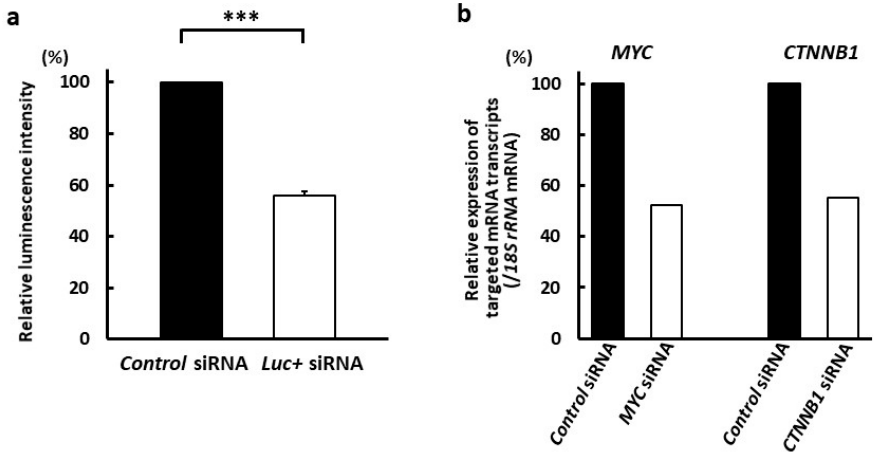
Figure 7. Successful suppression of targeted molecules in MM cells by anti-CD63 mAb-conjugated siRNA complexes. ( a ) Luminescence activity was significantly decreased in OPM-2 MM cells treated with luc+ siRNAs compared with in cells treated with control siRNAs (*** p < 0.005). The anti-CD63 mAb-Arg linker:siRNA ratio was 1:1 (1500 nM). Data are presented as mean ± standard error of two independent experiments (four wells per experiment). ( b ) The targeted mRNA transcripts decreased in OPM-2 MM cells treated with MYC or CTNNB1 siRNAs compared with those in cells treated with control siRNA. The anti-CD63 mAb-Arg linker:siRNA ratio was 1:1 (1500 nM). Data show the representative of two independent experiments.